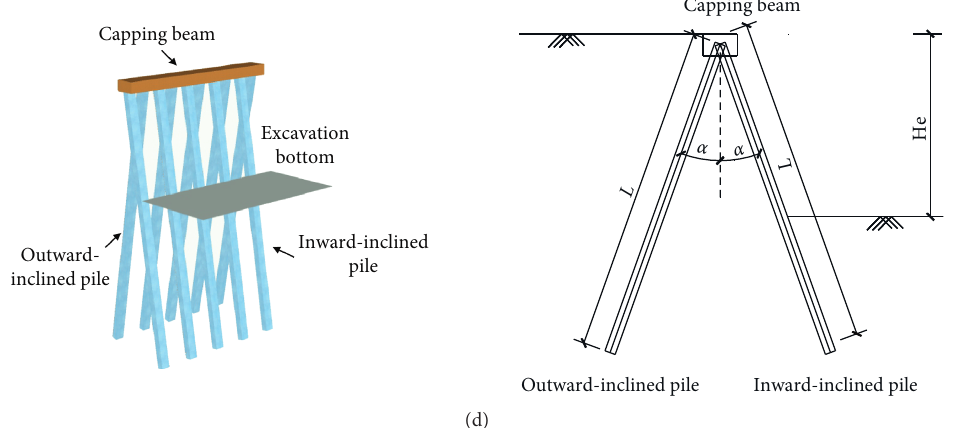
Figure 1: 3D diagram and profile of different types of inclined retaining structures. (a) Inclined piles (IP). (b) Vertical and outward-inclined piles (VOIP). (c) Vertical and inward-inclined piles (VIIP). (d) Outward- and inward-inclined piles